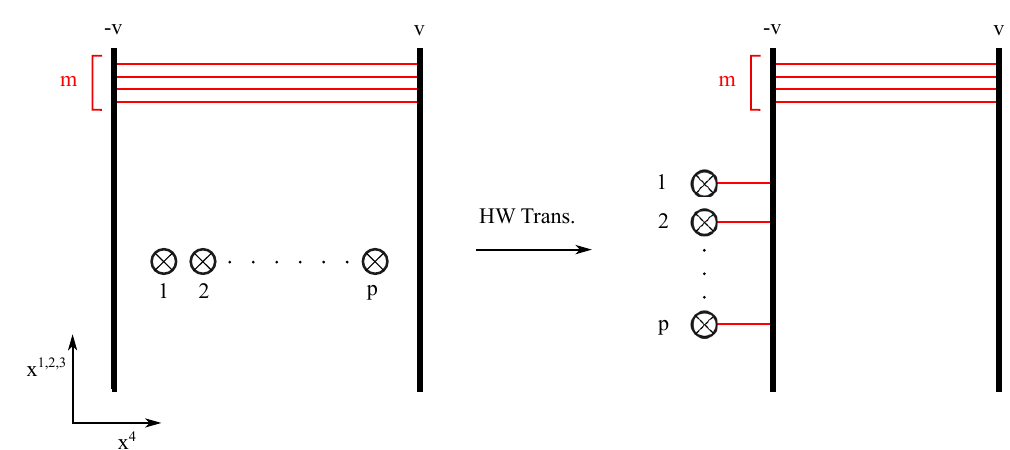
Figure 2 . This (cid:12)gure illustrates how Hanany-Witten transformations are realized for a brane con(cid:12)guration of transverse D1- (red), D3- (black) and NS5-branes ( (cid:10) ). Here we also see that by performing a series of Hanany-Witten moves the NS5-branes source magnetic charge in the D3-brane world volume